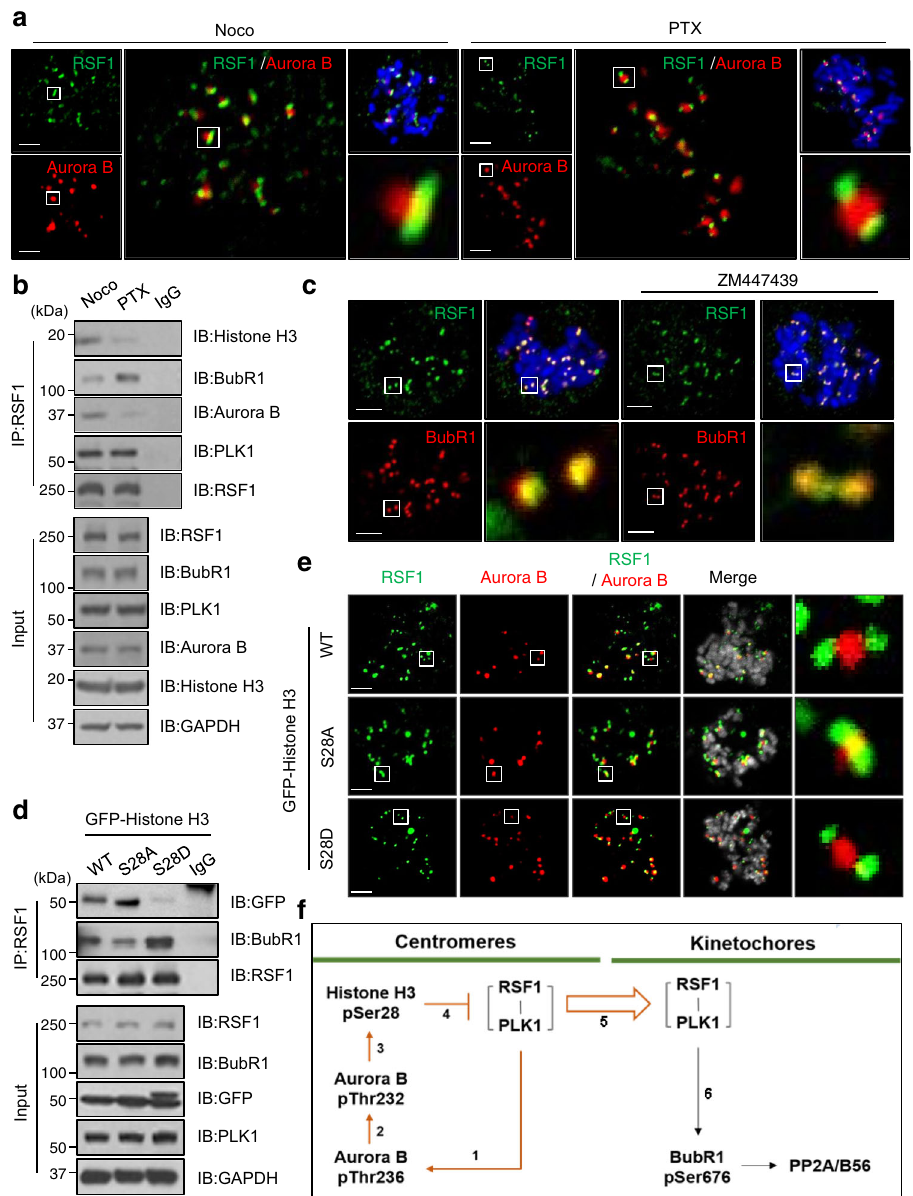
Fig. 7 RSF1 localization to mitotic kinetochores requires the phosphorylation of histone H3 on Ser28. a HeLa cells were treated with nocodazole or paclitaxel for 4h and prometaphase cells were stained with anti-RSF1 (green) and anti-Aurora B (red) antibodies. Scale bars, 5 μ m. b Nocodazole- or paclitaxel- treated HeLa cells were immunoprecipitated using anti-RSF1 antibodies. The inputs and immunoprecipitants were analyzed by western blotting. c HeLa cells were treated with paclitaxel treated for 4h and prometaphase cells were pre-treated with Aurora B inhibitor ZM447439 for 30min in the presence of MG132. Mitotic HeLa cells were stained with anti-RSF1 (green) and anti-BubR1 (red) antibodies. Scale bars, 5 μ m. d HeLa cells were transfected with indicated GFP-Histone H3 WT or S28A/D constructs and treated with paclitaxel for 16h. Mitotic cell lysates were followed by immunoprecipitation using anti-RSF1 antibody. e HeLa cells were introduced with GFP-Histone H3 WT or S28A/D mutants and treated with paclitaxel for 4h. Images were obtained from representative mitotic cells: RSF1 (green), Aurora B (red), and GFP (gray). Scale bars, 5 μ m. f A proposed model for spatiotemporal regulation of the on/off switch on Aurora B kinase by the RSF1-PLK1 axis. New fi ndings are colored in orange lines. Data of b , d are representative of three independent experiments. Source data are provided as a Source Data fi